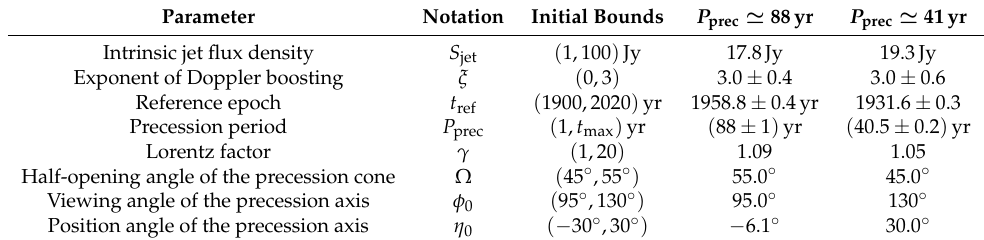
Table 1. Table of fitted parameters in the precession model with the initial parameter bounds as indicated in the third column. The first column contains the parameter name, the second column lists the notation, the third one contains the initial bounds for the Levenberg–Marquardt algorithm [44,45], and the fourth and the fifth columns contain the fitted values for the longer and the shorter precession periods,